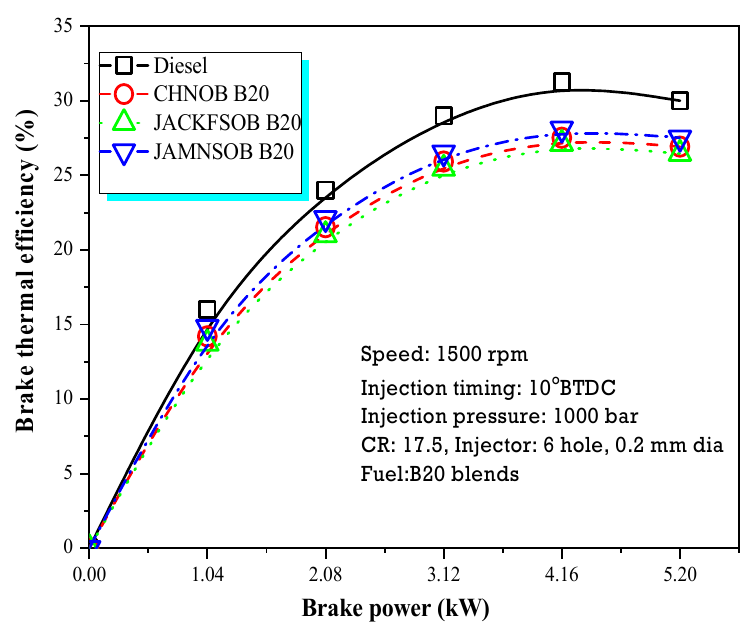
Figure 6. Variation of BTE vs. BP.